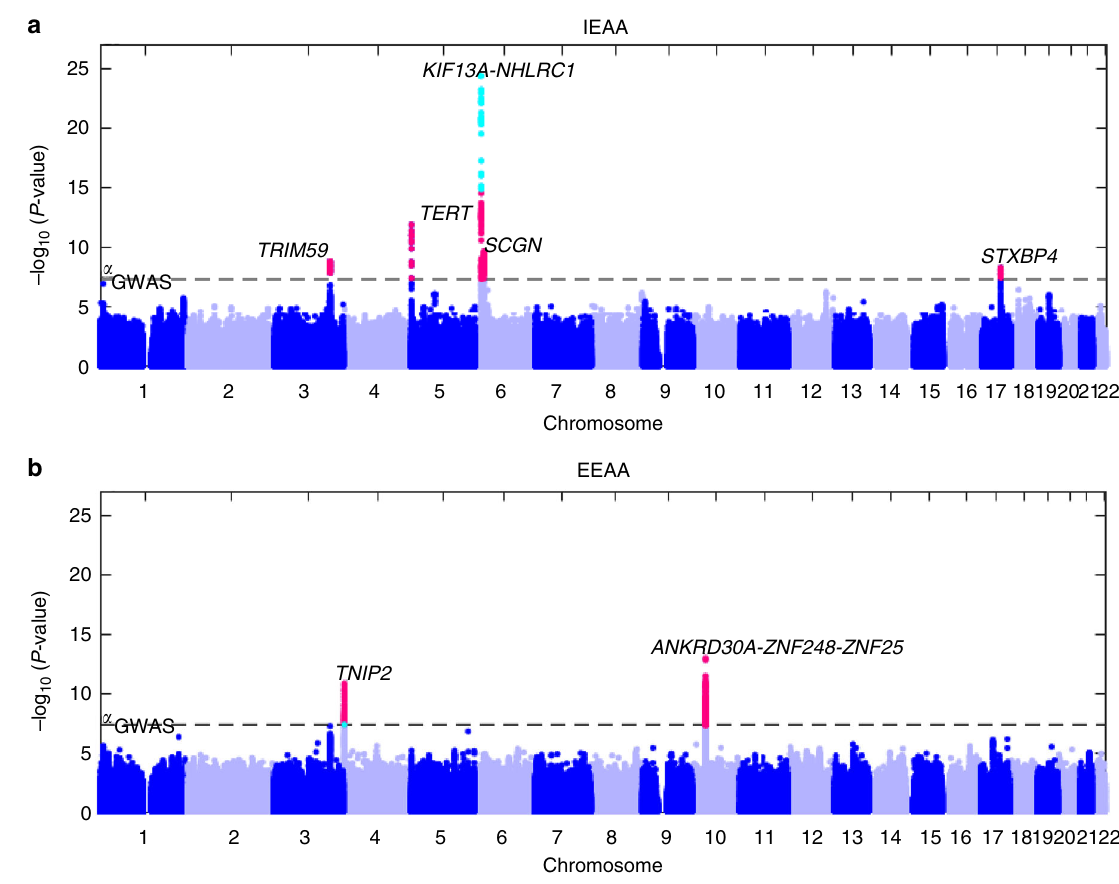
Fig. 2 Genome-wide meta-analysis for intrinsic and extrinsic age acceleration in blood. Manhattan plots for the meta-analysis P -values resulting from 15 studies comprised of 9907 individuals. The y -axis reports log transformed P -values for a intrinsic epigenetic age acceleration (IEAA) or b extrinsic epigenetic age acceleration (EEAA). The horizontal dashed line corresponds to the threshold of genome-wide signi fi cance ( P = 5.0 × 10 − 8 ). Genome-wide signi fi cant common SNPs (MAF ≥ 5%) and low frequency SNPs (2% ≤ MAF < 5%) are colored red and cyan,